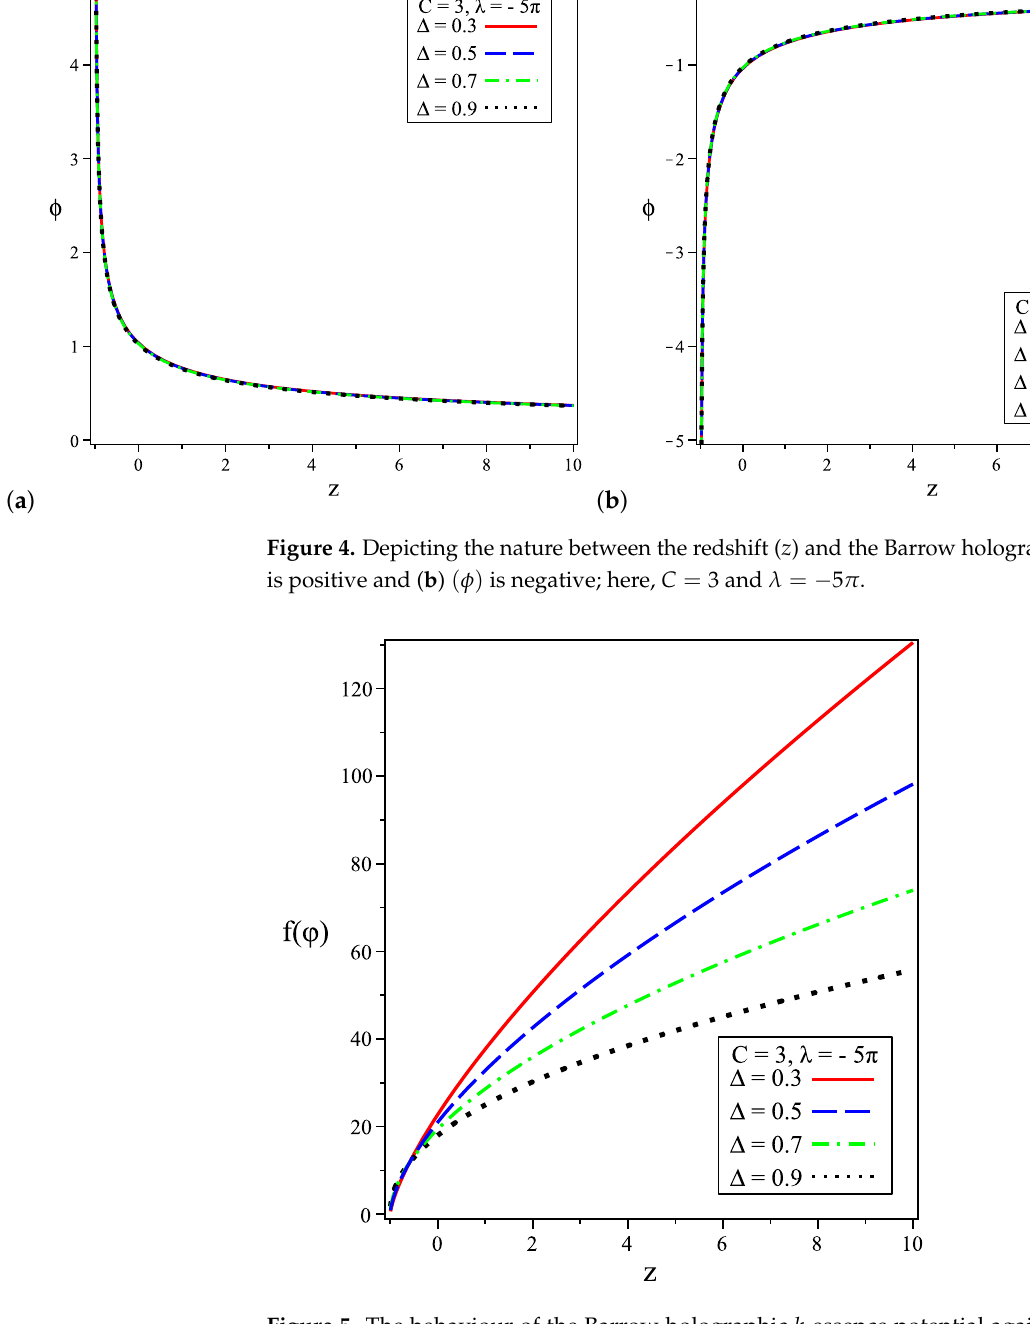
Figure 5. The behaviour of the Barrow holographic k -essence potential against redshifts ( z ); here, C = 3 and λ = − 5 π